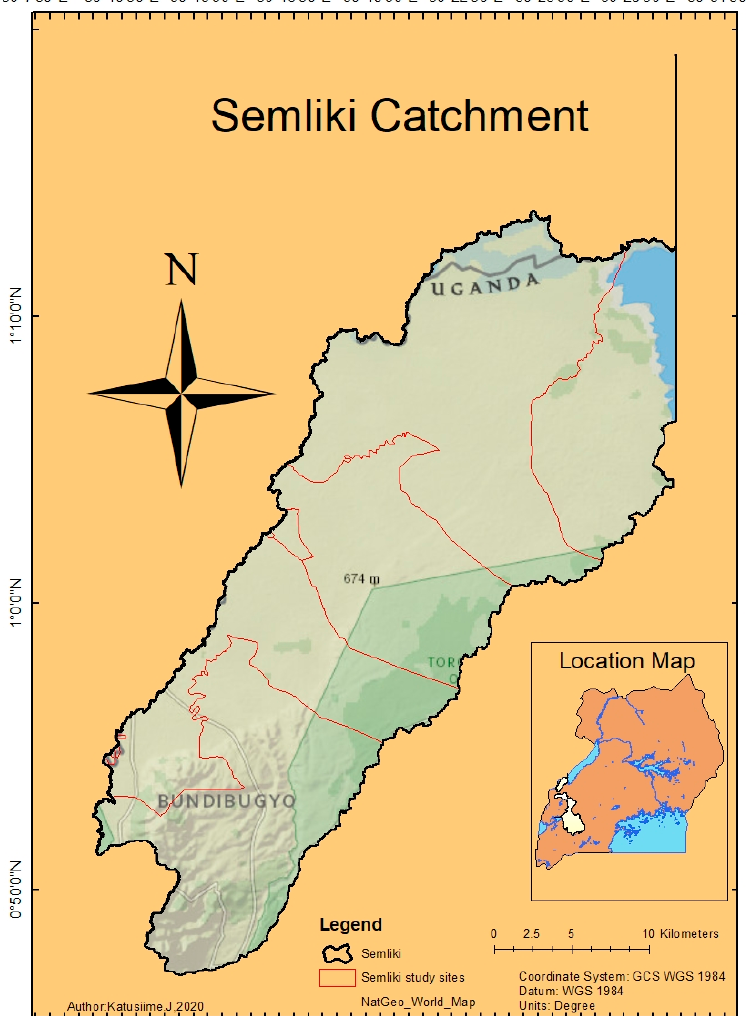
Figure 2. A section of the river Semliki catchment indicating the sample study site’s relief topography and a portion of the Uganda-Congo (DRC) Boarder.